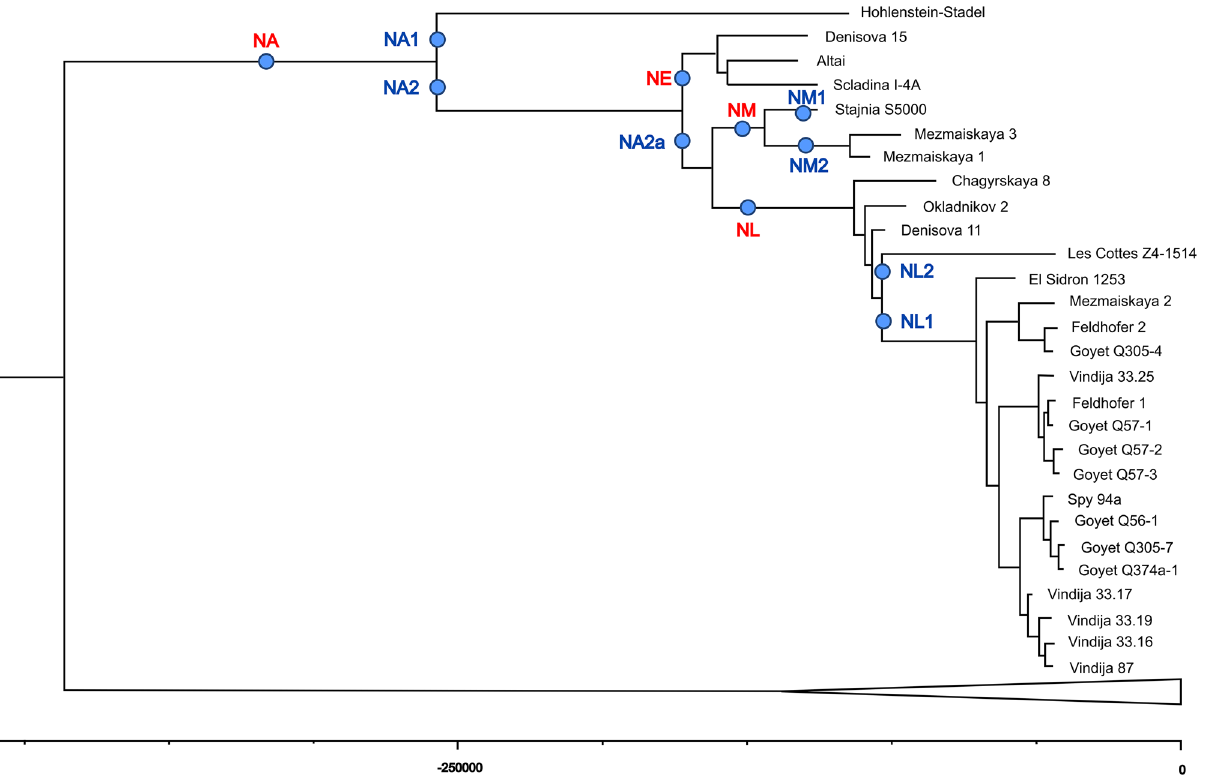
Figure 3. Bayesian phylogenetic tree relating the Mezmaiskaya 3 to other archaic and modern human mitochondrial genomes. The branches corresponding to modern human mtDNAs are collapsed at the bottom of the figure. The tree was reconstructed by only using coding sequences. Neanderthal’s haplogroups are indicated for the main branches.